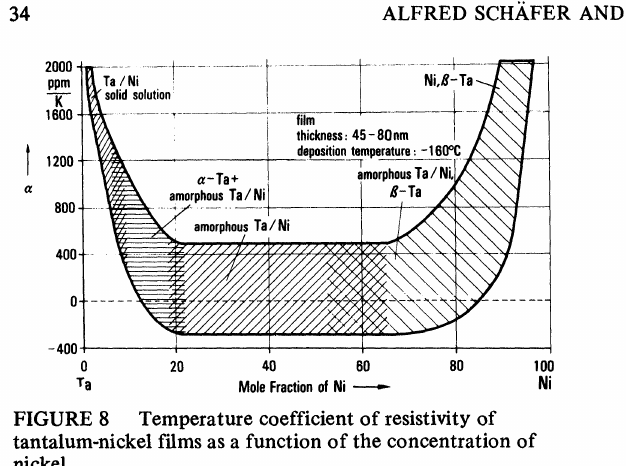
FIGURE 8 Tempratur coefficient of resistifity of tanta[um-nickl films as a function of the conccntration of ckel.